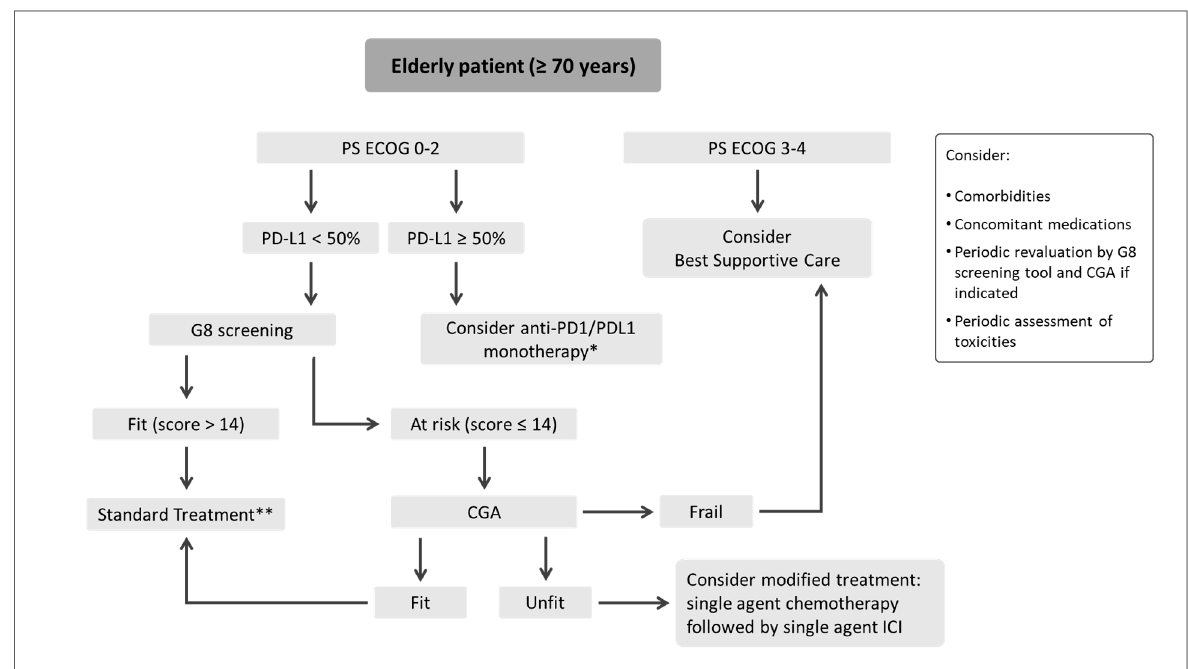
Figure 1. Proposal for a decision algorithm in elderly patients with NSCLC. * G8 screening should be done also in patients with PD-L1 TPS ≥ 50%. Combination therapy should be considered with due caution, given the effectiveness of single agent immunotherapy. Best supportive care alone could be an option for patients found frail at CGA. ** Chemotherapy plus immunotherapy should be considered. The association of double ICIs plus chemotherapy should be carefully evaluated, given the loss of survival benefit in patients older than 75 years. Patients with PS ECOG 2 and PD-L1 TPS < 50% should be considered for non-platinum single-agent chemotherapy followed by single-agent